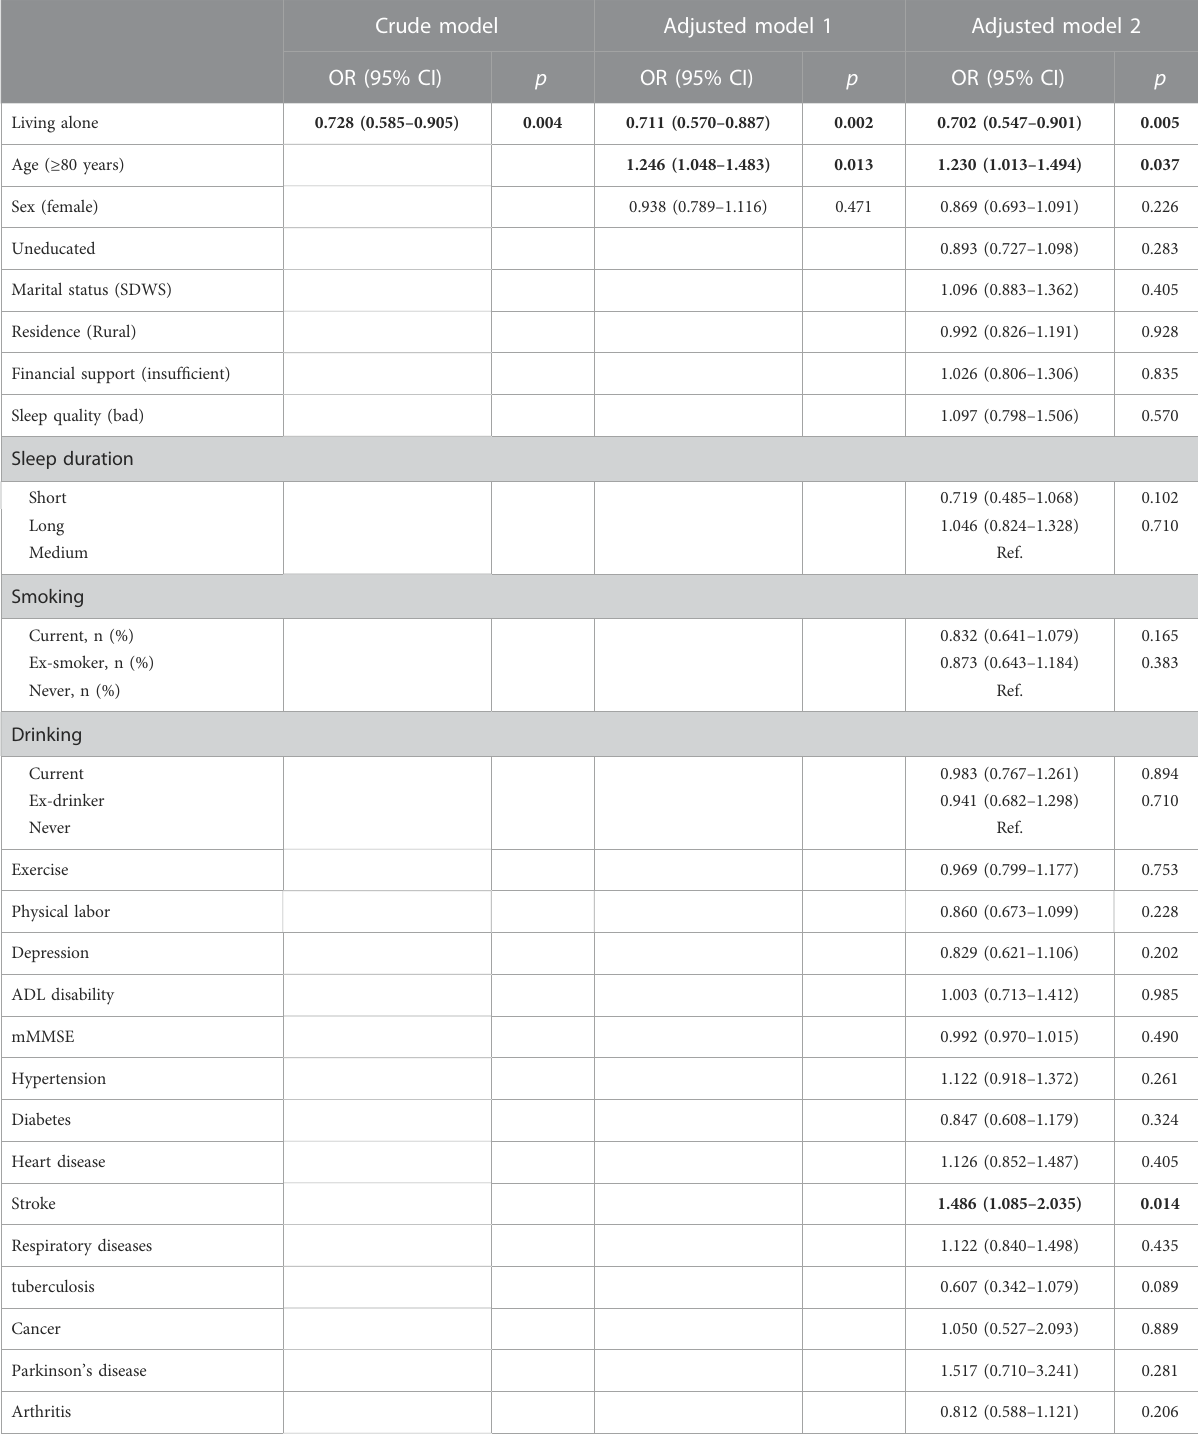
TABLE 2 Associations between CC decline and living arrangements by logistic regression